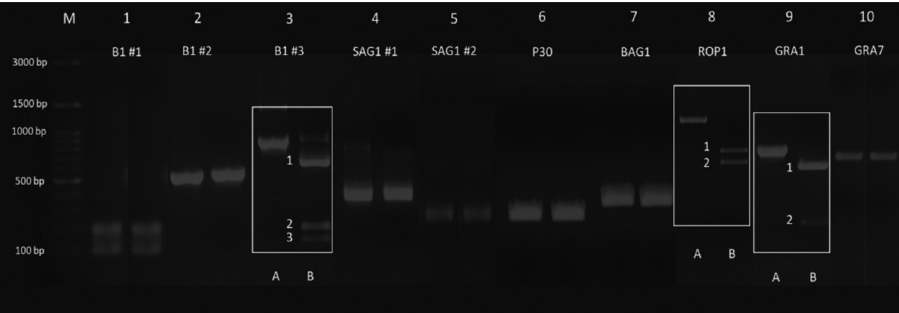
Figure-1: Toxoplasma gondii nucleic acid amplified by various gene targets. Polymerase chain reaction-restriction fragment length polymorphism (PCR-RFLP) patterns of T. gondii virulent strain of B1 (#1, #2, and #3), SAG1 (#1 and #2), P30, BAG1, ROP1, GRA1, and GRA7 cut with DdeI . The PCR product was resolved on 1.5% agarose stained with SYBR™ safe staining. Lane M: Geneaid 100 bp DNA ladder, A: PCR conventional, B: Restriction pattern of PCR-RFLP (1, 2, and